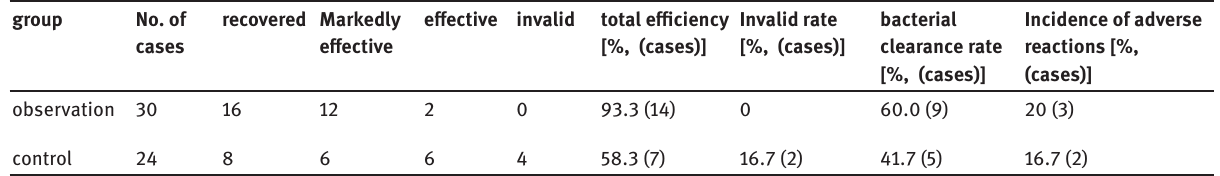
Table 2: Comparison of results in the two groups. group No. of